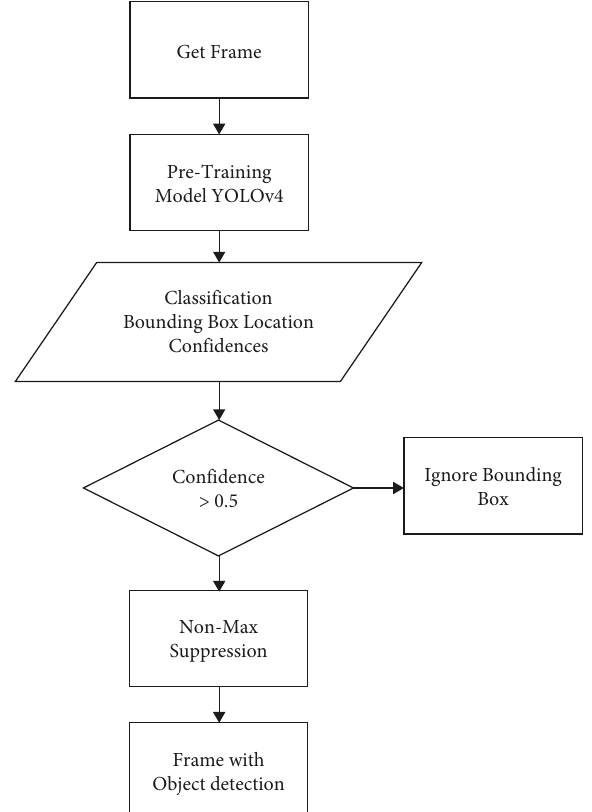
Figure 16: Diagram of obstacle identification